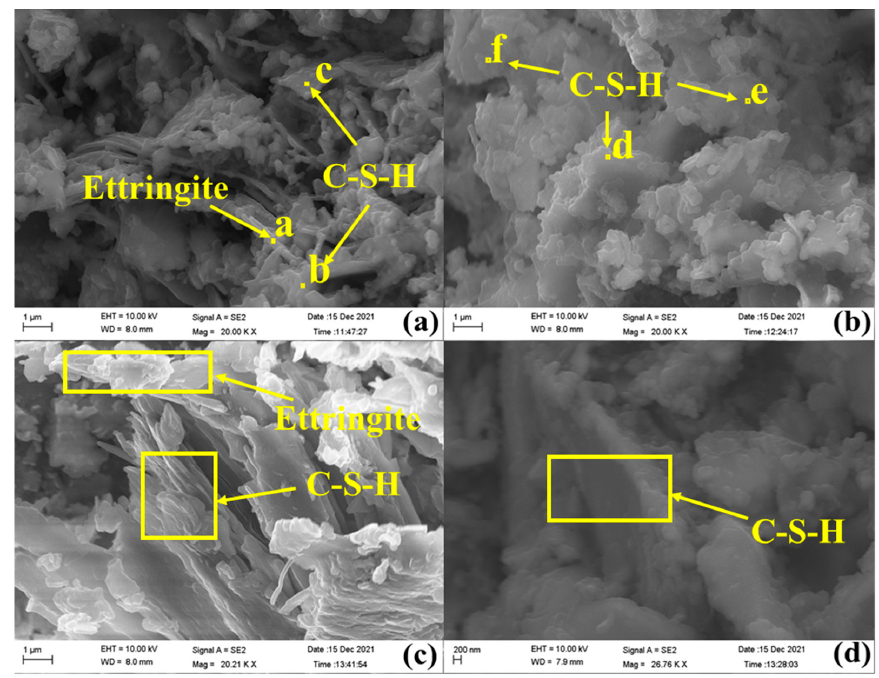
Figure 5. SEM images of sample 7 ( a , b ) on day 28 and ( c , d ) on day 90. Table 3. EDS results of sample 7 on day 28 and day 90 .